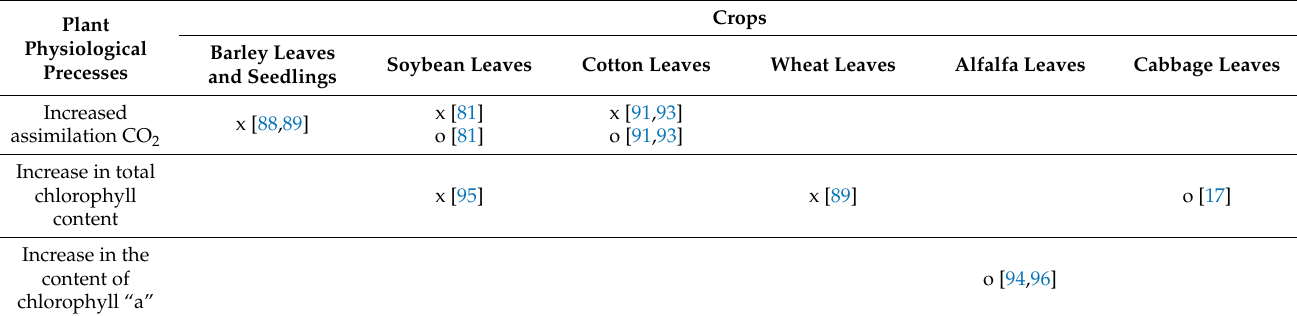
Figure 2. Influence of auxins and cytokinins on the process of CO 2 assimilation in plants. Table 1. Influence of auxin and cytokinin on plant physiological processes in various